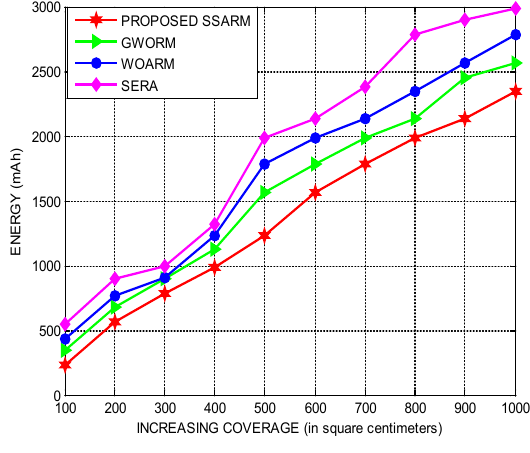
Figure 10. Proposed SSARM-Energy Utilized with Increasing Coverage